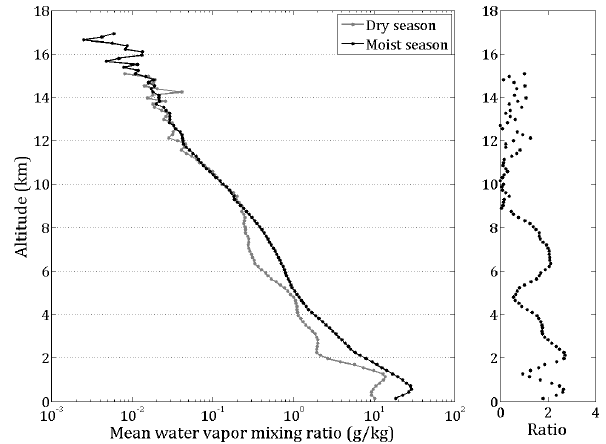
Fig. 7. Mean water vapour mixing ratio vertical profiles during the period 2002–2005 regarding the moist and dry season (left panel) Figure 7. Mean water vapor mixing ratio vertical profiles during the period 2002-2005 3 and the ratio between the seasons (right regarding the moist and dry season (left panel) and the ratio between the seasons (right panel) 4